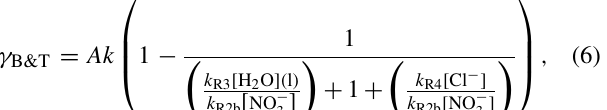
Figure 3. Diurnal variations in (a) N 2 O 5 and ClNO 2 ; (b) particulate NO − via reaction of OH + NO 2 and NO 3 + VOC; and (d) concentrations of NH + is the local time and the shaded areas (yellow) represent the